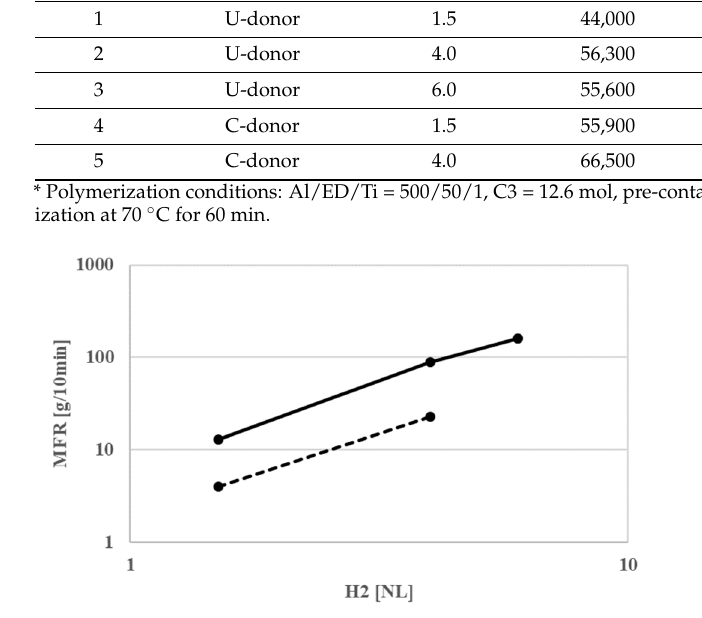
Figure 1. H 2 response on MFR; Solid line : U-donor, Dotted line : C-donor.